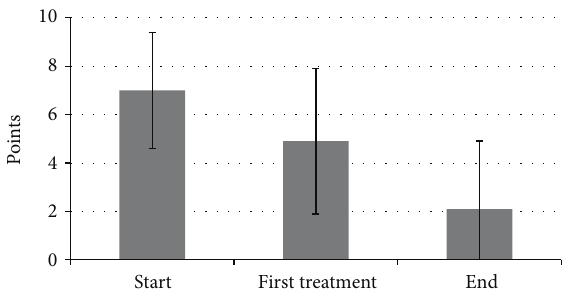
Figure 5: Shin splint score in